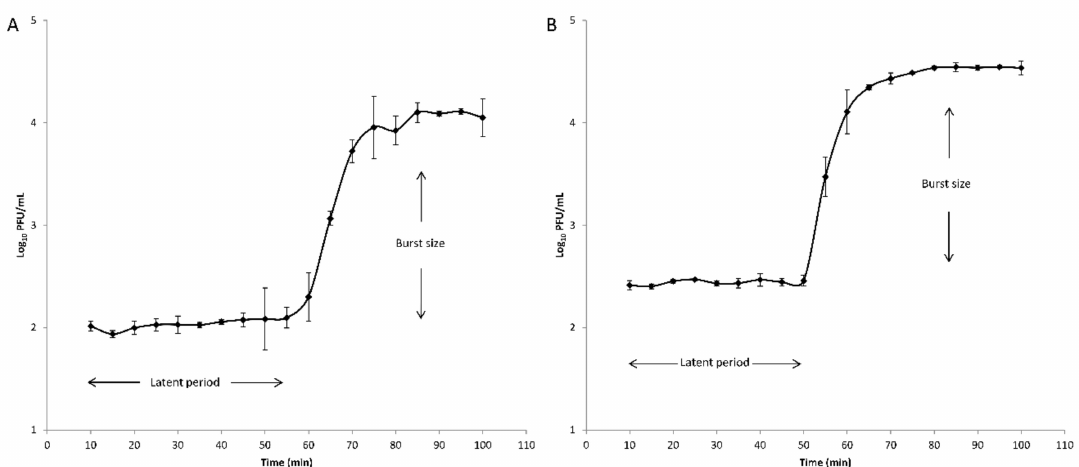
Figure 2. One-step growth curves of the phage ( A ) V523 and ( B ) V524. The error bars represent the standard deviations for technical triplicates. The latent periods and the burst sizes are indicated.